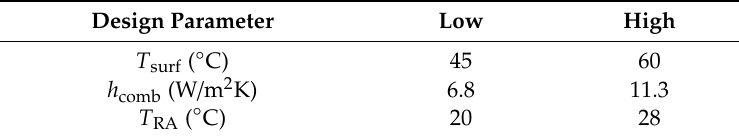
Table 3. Valid ranges of the developed empirical